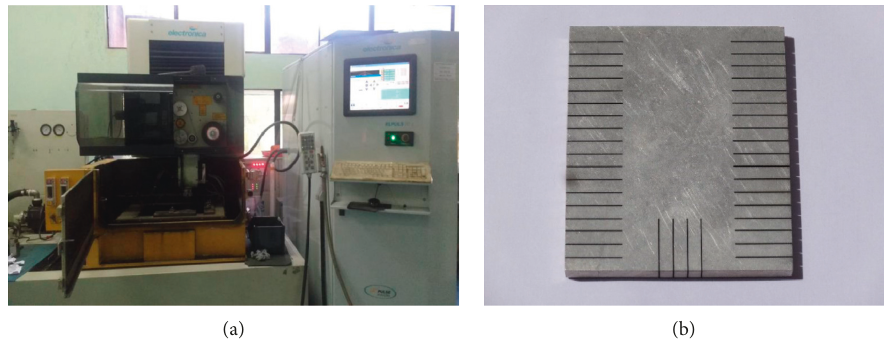
Figure 3: (a) NPMD-WEDM experimental facility and (b) experimental work